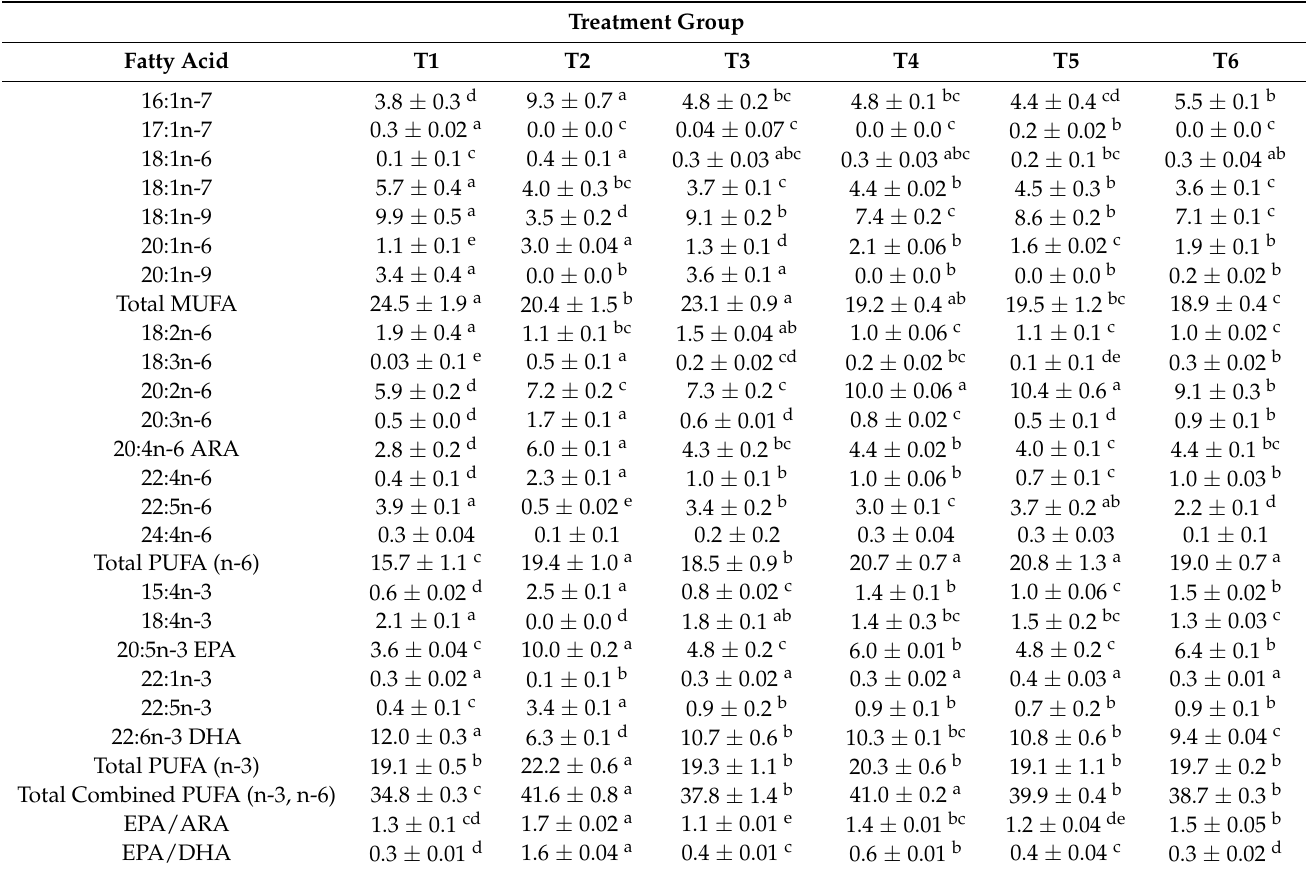
Values are given as a percentage of total fatty acids. Data are presented as means ± SD ( n = 3). Different superscript letters indicate significant differences among groups. Means were compared using one-way analysis of variance (ANOVA), with p < 0.05 considered